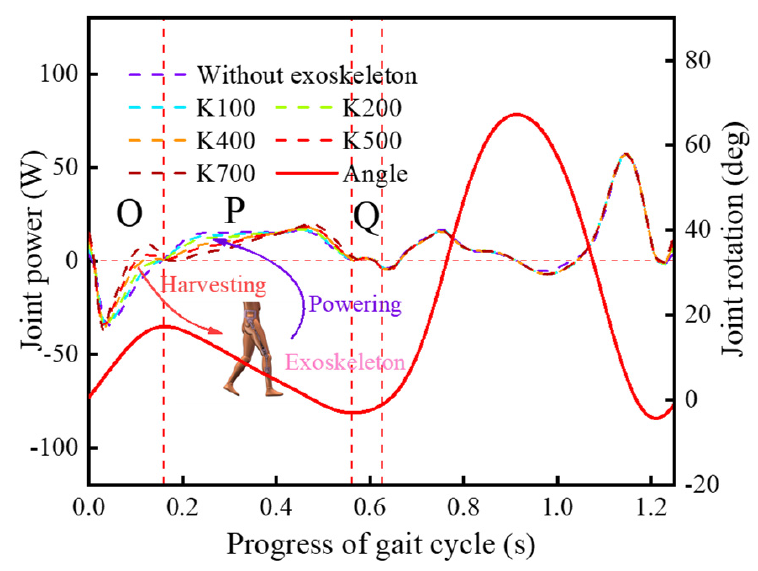
Figure 12. Joint power with the KESM under different stiffness values. There were significant amplitude differences between the joint powers during the support period and the high similarity during the swing period [25,28]. This indicates that the KESM affects the body during the support period, and this interaction has a positive effect on the movement of the knee joint. To objectively judge the walking-assistance efficiency of the KESM, this paper introduced a calculation formula to measure the overall distribution of the knee joint power, which is based on the consideration of the discrete data results. The formula based on the average is shown in Equation (14), and the limit walking-assistance efficiency formula of the KESM is defined in Equation (15).